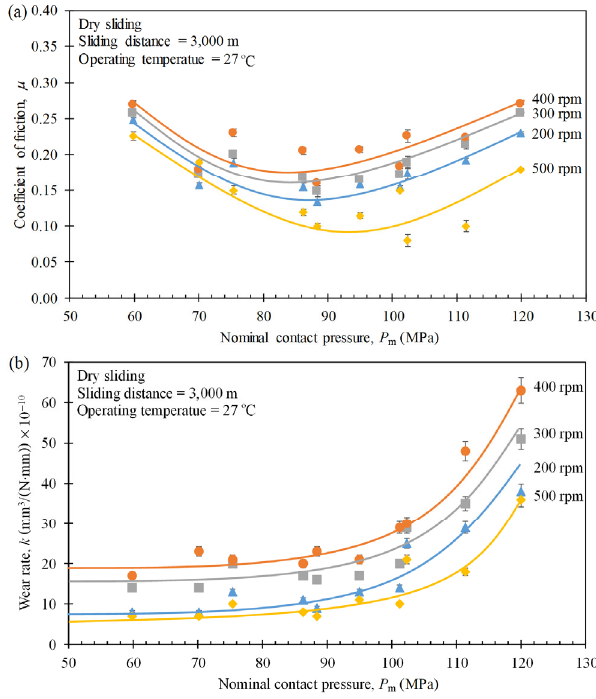
Fig. 3 Effect of contact pressure on the (a) friction coefficient and (b) wear rate of an activated carbon-epoxy composite derived from palm kernel at different sliding speeds. The error bar is for the standard